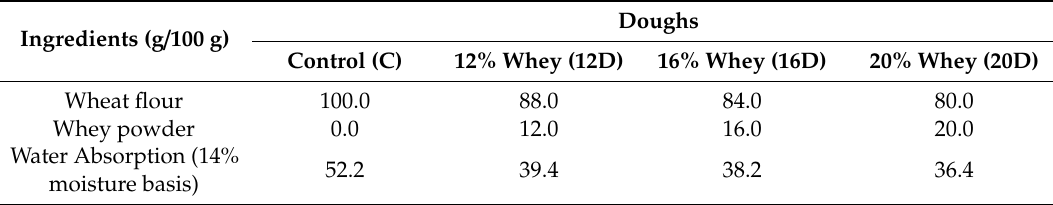
Table 1. Bread dough samples formulation and respective